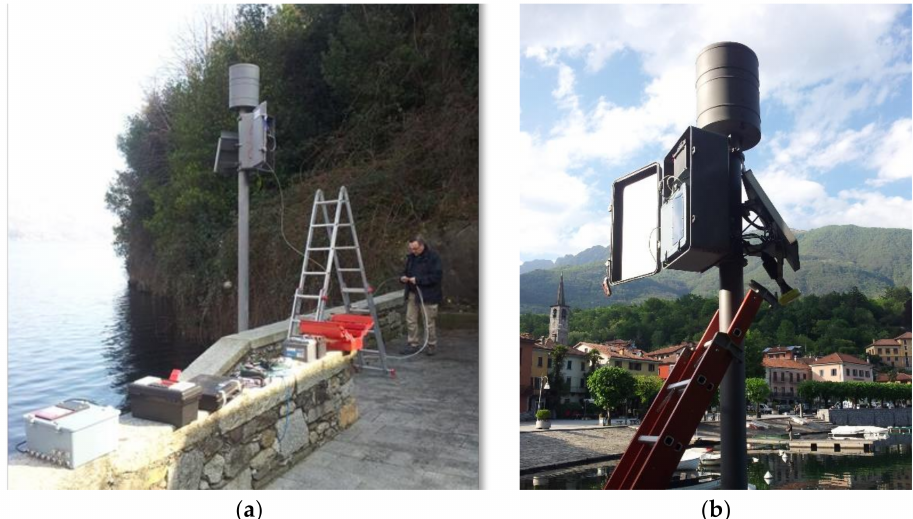
Figure 3. Hydro-meteorological station of Lake Mergozzo: ( a ) upgrade of Mergozzo hydro- meteorological station with new sensors and IOT electronic board; ( b ) main elements of hydrometeo- rological station of Lake Mergozzo: pluviometer, robust shell that contains electronic elements, solar panel, and